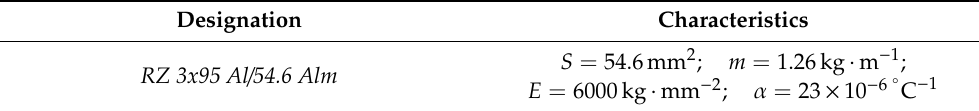
Table 4. Characteristics of cable RZ 3x95 Al / 54.6 Alm .